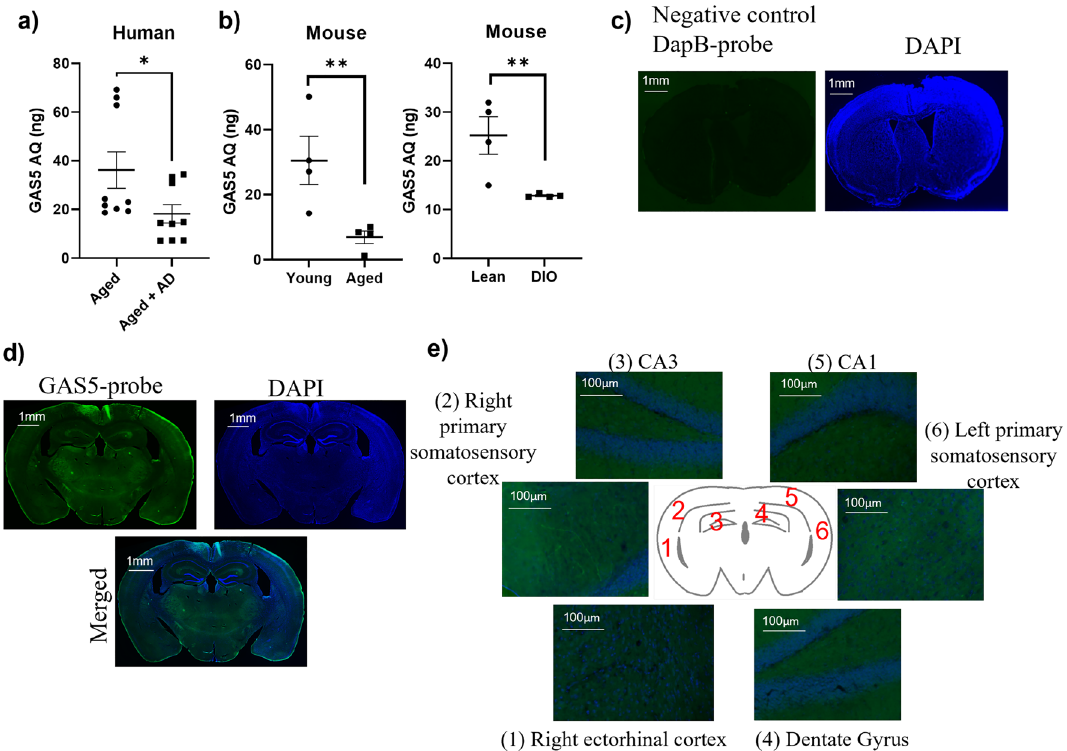
Figure 1. GAS5 levels in brain ( a ) QPCR was performed on RNA isolated from human temporal lobe from aged and aged-matched patients with Alzheimer’s Disease (no cancer, aged 70–85 yr, M/F, n = 9 each). A standard curve was generated for GAS5 expression levels and absolute quantification (AQ; ng) was calculated and normalized to β-actin expression. Statistical analysis was performed by two-tailed Student’s t-test, *p < 0.05. ( b ) Hippocampal tissue was harvested from C57BL6 mice 6-month-old mice (Young) or 20 month old mice (Aged), or littermates fed with control chow (Lean) or high fat diet to generate diet induced obese mice (DIO). RNA was isolated and qPCR was performed for GAS5 levels. A standard curve was generated for GAS5 expression levels and absolute quantification (AQ, ng) was performed normalized to β-actin expression (n = 4). Statistical analysis was performed by two-tailed Student’s t-test, **p < 0.01. ( c ) All sections were treated with Sudan black B (SBB) dye to eliminate autofluorescence and nuclear counterstained with DAPI. DapB was used as negative control probe in RNAscope. ( d ) Representative image of GAS5 in situ hybridization (GAS5-ISH) in whole mouse brain section. Scale bar represents 1 mm e) Representative 20 × images of GAS5-ISH insets of the (1) ectorhinal cortex, (2) and (6) primary somatosensory cortex, (3) CA3, (4) dentate gyrus, and (5) CA1 are shown.; inset scale bar represents 100